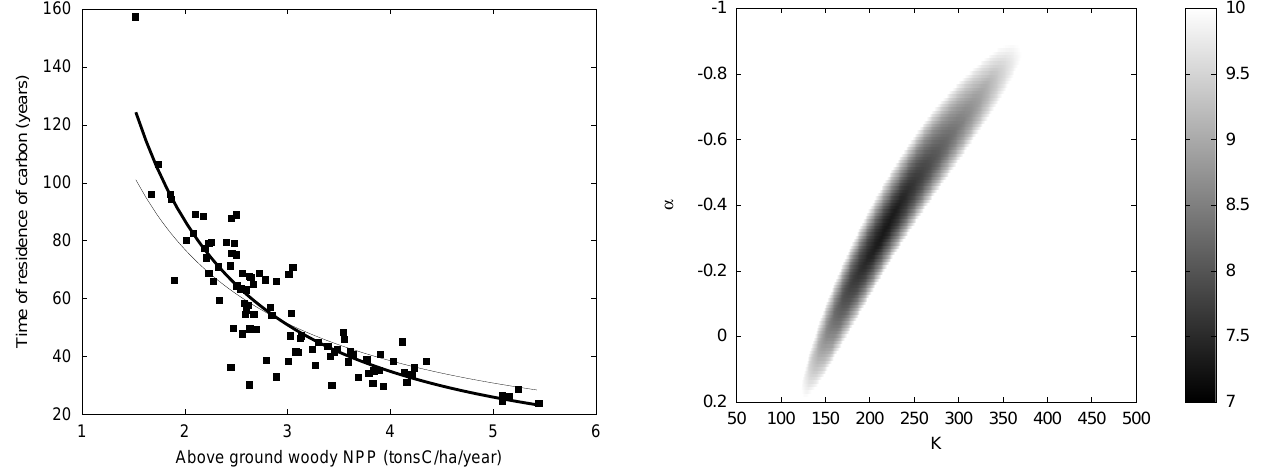
Fig. 6. Average absolute difference (years) between the computed Fig. 5. time of residence of carbon in wood plotted versus t residence (from Eq. 7) and the ground measurements (Malhi et al., NPP AGW . Squares : ground measurements from Malhi et al. 2004. 2004) in a systematic exploration of the values of α and Bold line represents the best overall fit: t residence =217 × NPP − 1 . 32 AGW (average absolute error: 7.30 years). Thin line represents the best fit for α =0: t residence =154 × NPP − 1 (average absolute error : AGW 8.6 years).